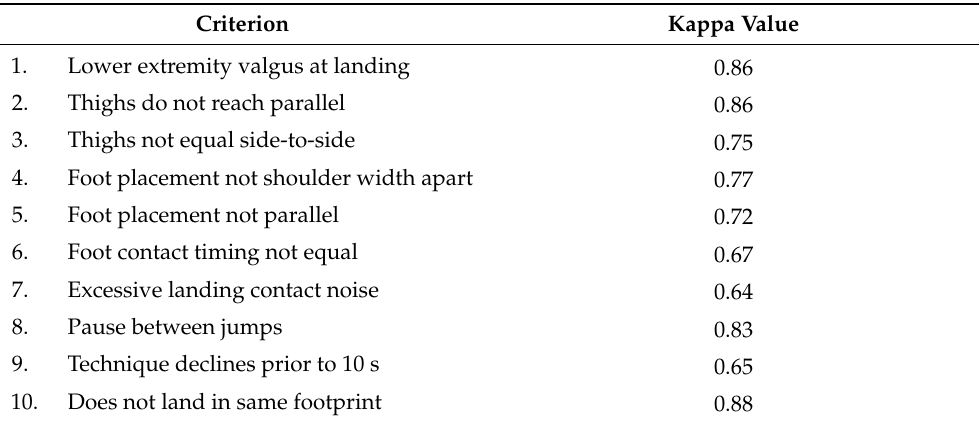
Table 3. Descriptive data of the participants (mean ± standard deviation).